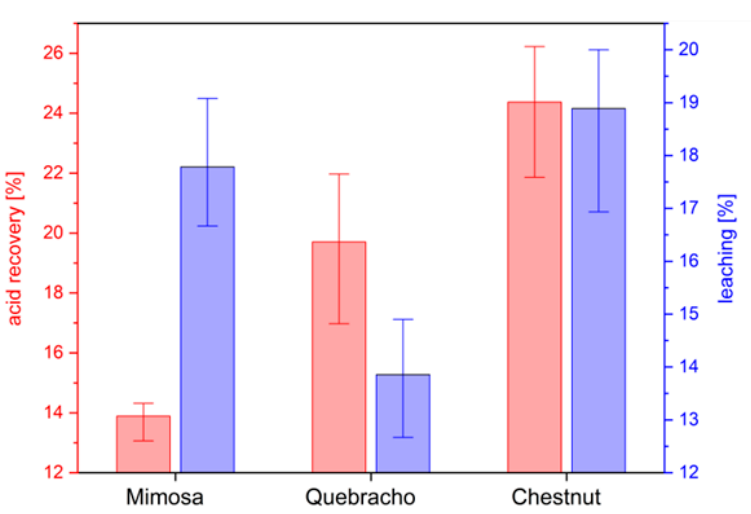
Figure 5. Percentage of recovered acid and leached polymer for the different tannin foam formulations produced at 5% surfactant concentration.